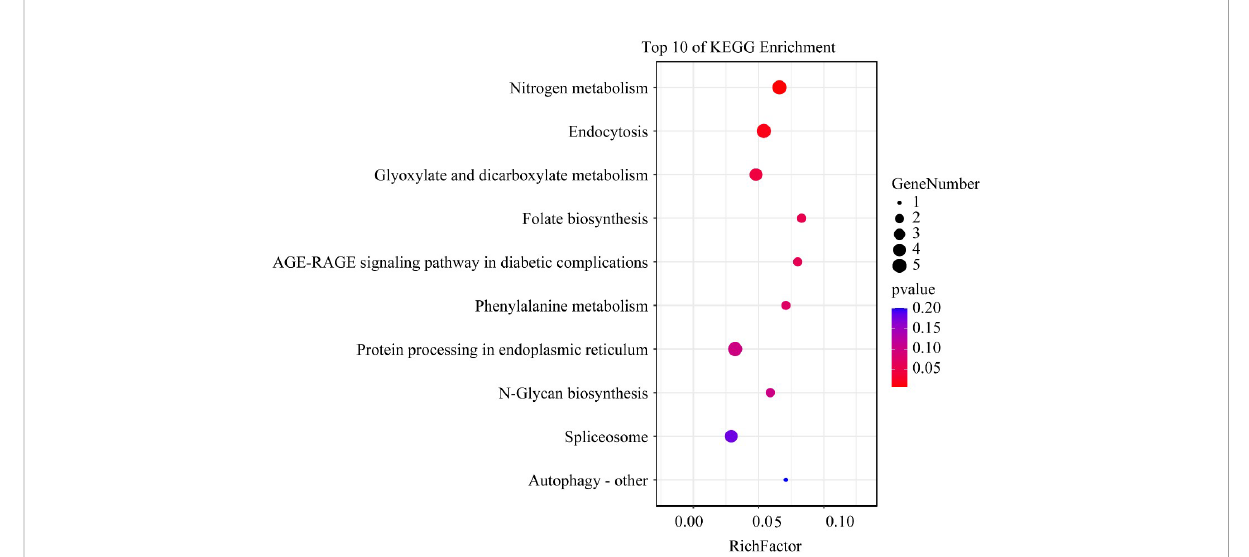
FIGURE 5 The top 10 enriched KEGG pathway terms of H3K4me3 associated genes unique to the HL condition in Alexandrium paci fi cum . RichFactor represents the ratio of the number of genes located in the KEGG term to the total number of genes located in the KEGG term in all annotated genes. The size of the circle represents the number of genes enriched in the term. The gradient of color from blue to red represents the size of the p -value changes.